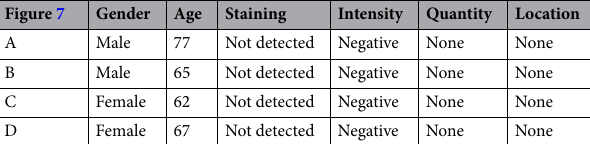
Table 6. Patient of expression of ITIH2 in CRC information sheet.